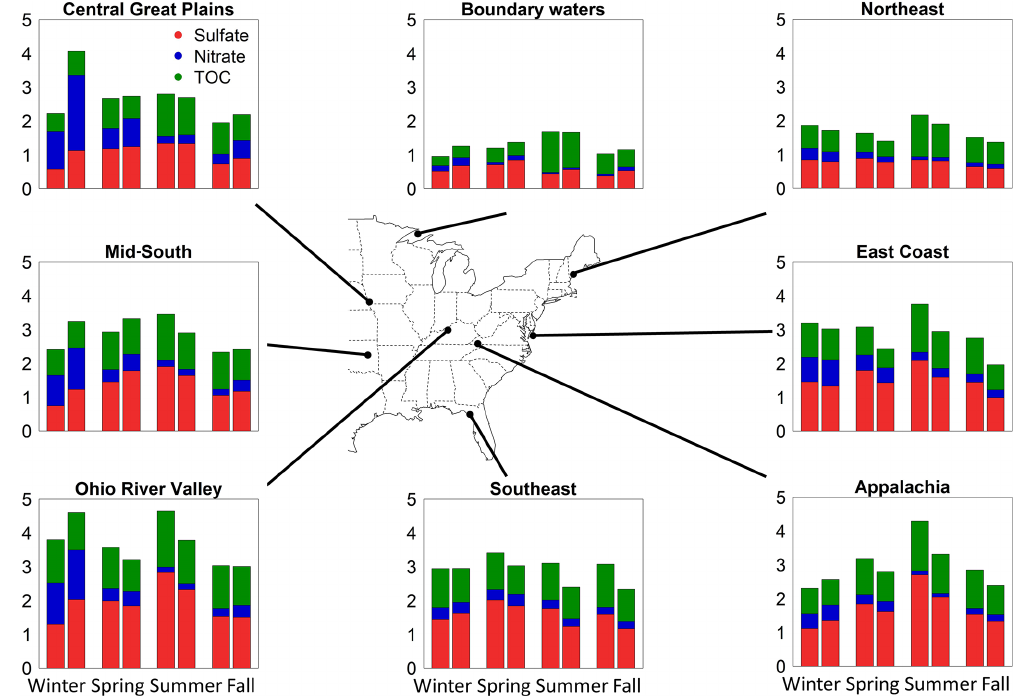
Figure 2. Seasonal median values of PM 2 . 5 chemical constituents in the eastern US during MODIS-defined clear-sky (left stacked bar in each pair) and cloudy (right stacked bar in each pair) conditions. Total organic carbon mass concentrations are nearly universally higher during clear-sky conditions in all regions, and this pattern is unique among PM 2 . 5 chemical